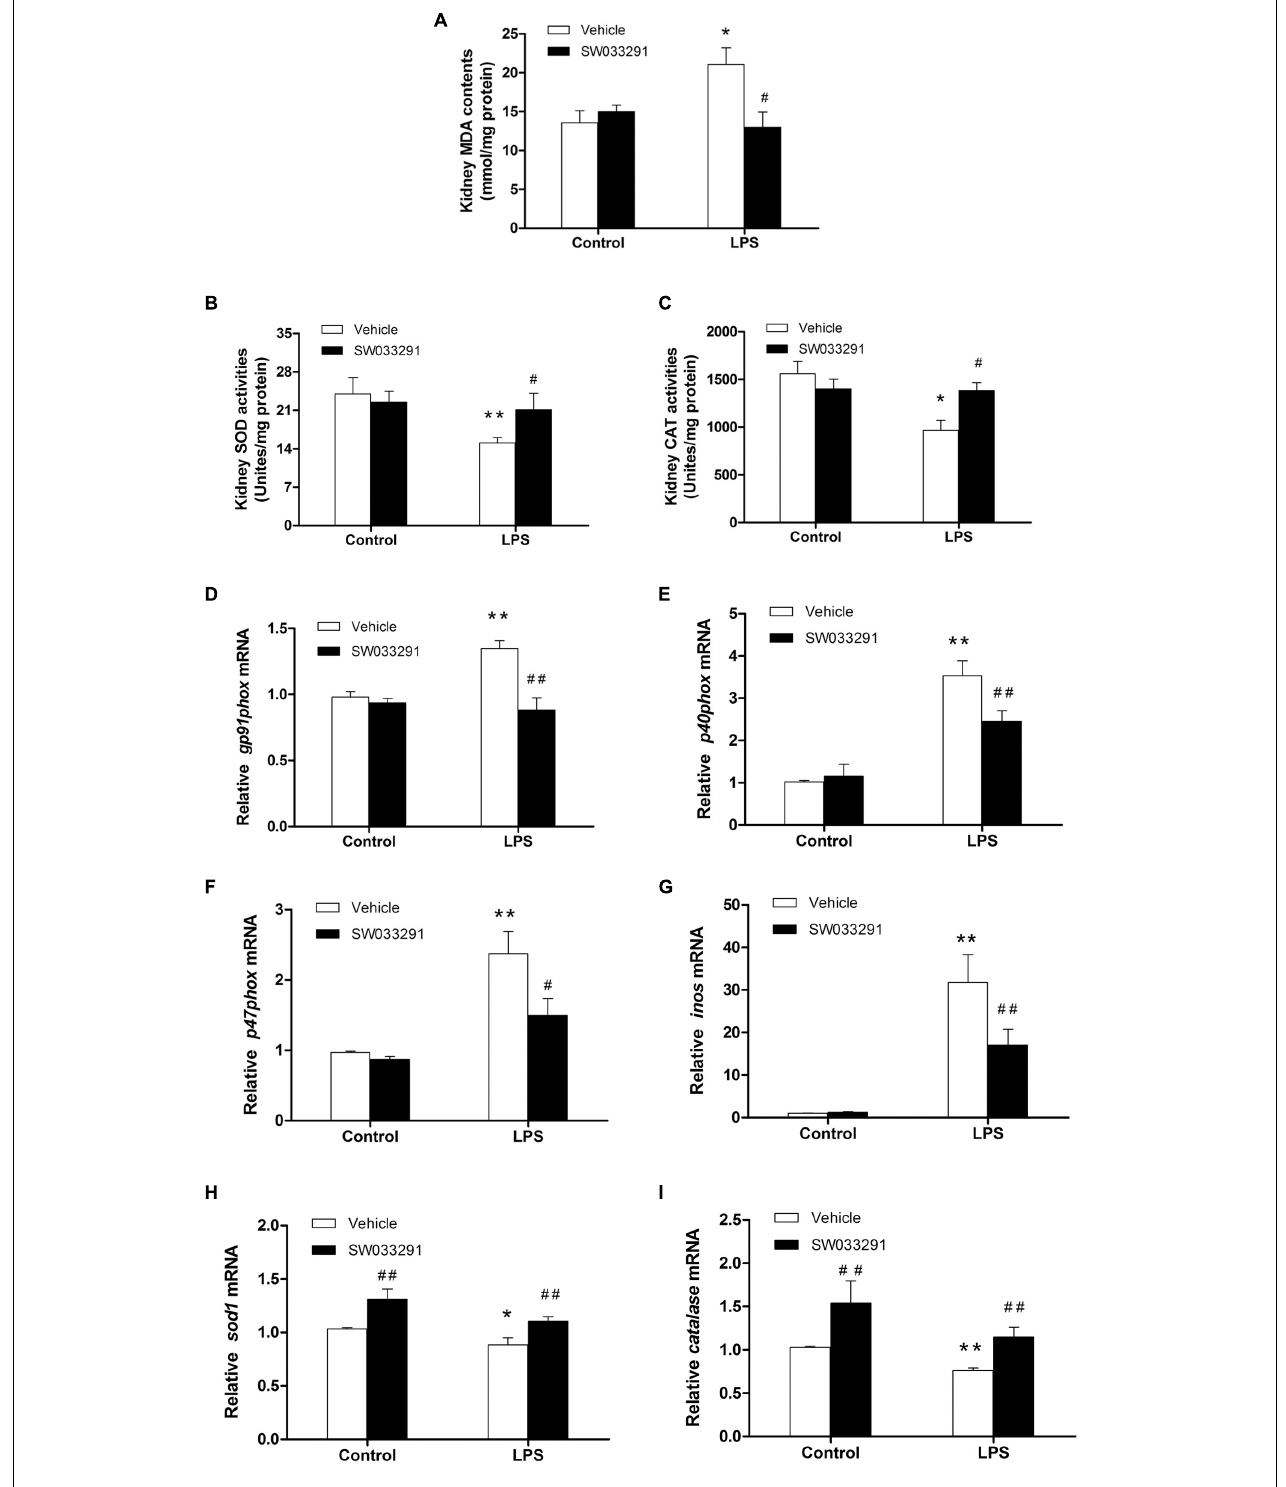
FIGURE 7 | Renal MDA level and the activity of SOD and CAT after SW033291 treatment. (A) Renal MDA level. (B) Renal SOD activity. (C) CAT activity. * P < 0.05, ** P < 0.01 vs. CON; # P < 0.05, ## P < 0.01 vs. LPS ( n ≥ 6). (D–F) Effect of SW033291 (10 mg/kg) treatment on the mRNA expression of NADPH oxidase subunits of gp91phox, p40phox, and p47phox in kidneys. (G) iNOS mRNA level. (H,I) Expression of antioxidant genes of SOD1 and catalase in the kidneys after SW033291 (10 mg/kg) treatment. * P < 0.05, ** P < 0.01 vs. CON; # P < 0.05, ## P < 0.01 vs. LPS; ( n = 6). Data are mean ± SD.